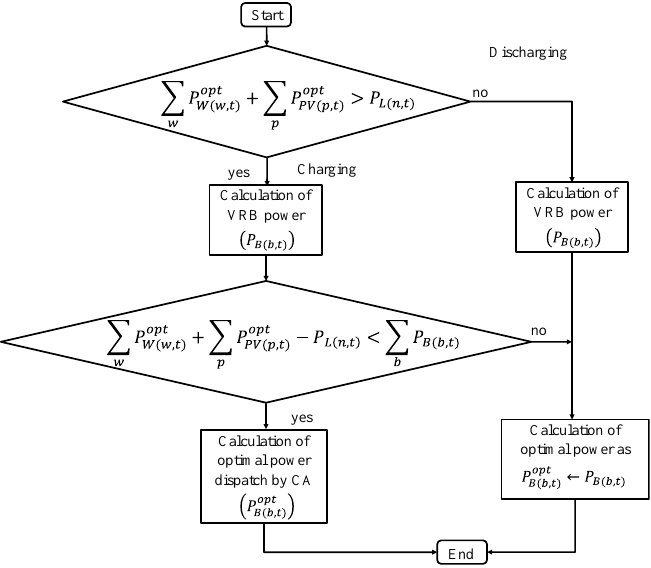
Figure 6. Flowchart of PV and wind power dispatch.